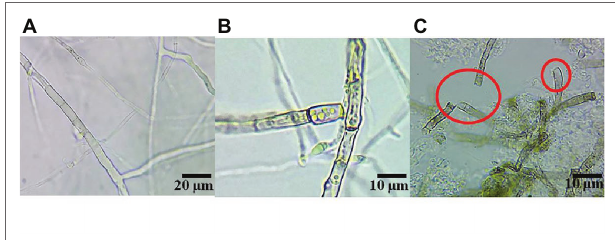
FIGURE 6 | The strain SL-44 suppressed mycelial growth of Rhizoctonia solani in different treatments of control (A) , 16 hpi (B) , and 24 hpi (C) treated with SL-44 culture filtrates.